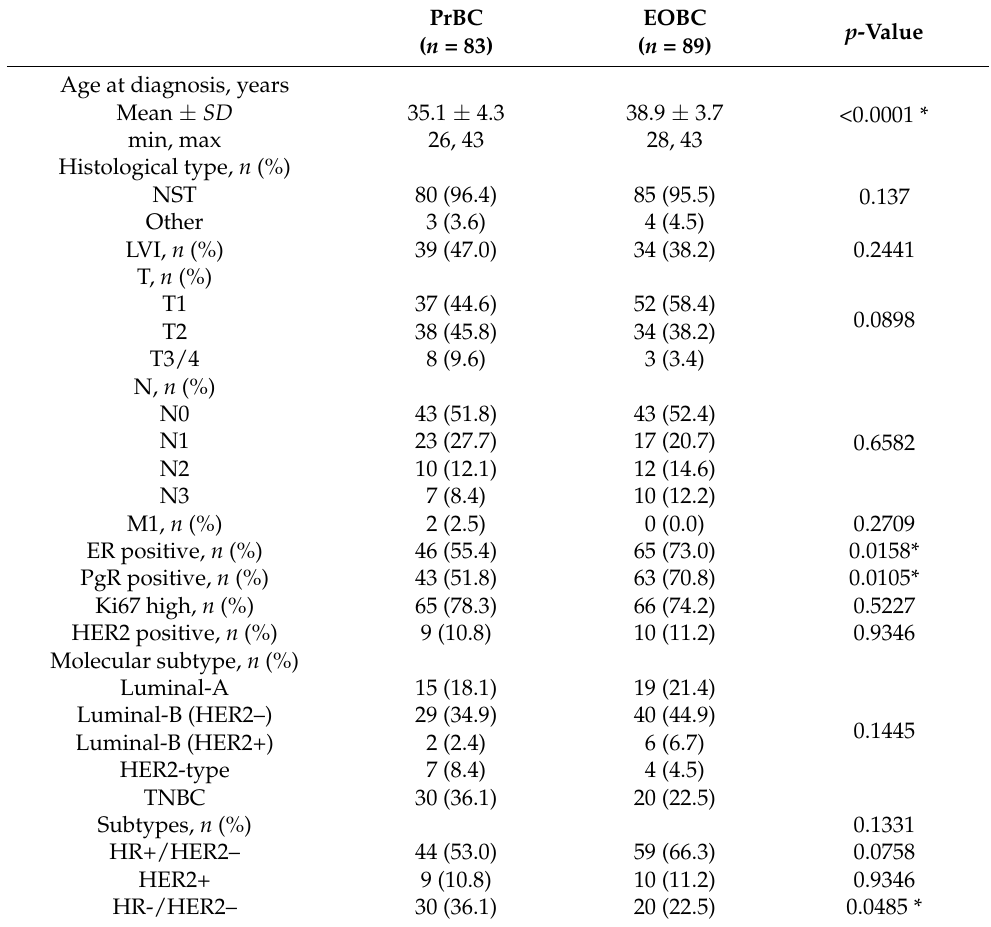
Table 1. Clinicopathological characteristics of the patients included in the study. PrBC, breast cancer during pregnancy; EOBC, early-onset breast cancers; standard deviation; SD, standard deviation; NST, no special type (aka ductal); LVI, lymph vascular invasion; ER, estrogen receptor; PgR, progesterone receptor; TNBC, triple-negative breast cancer. Significant correlations are highlighted with a star (*). PrBC EOBC p -Value ( n =